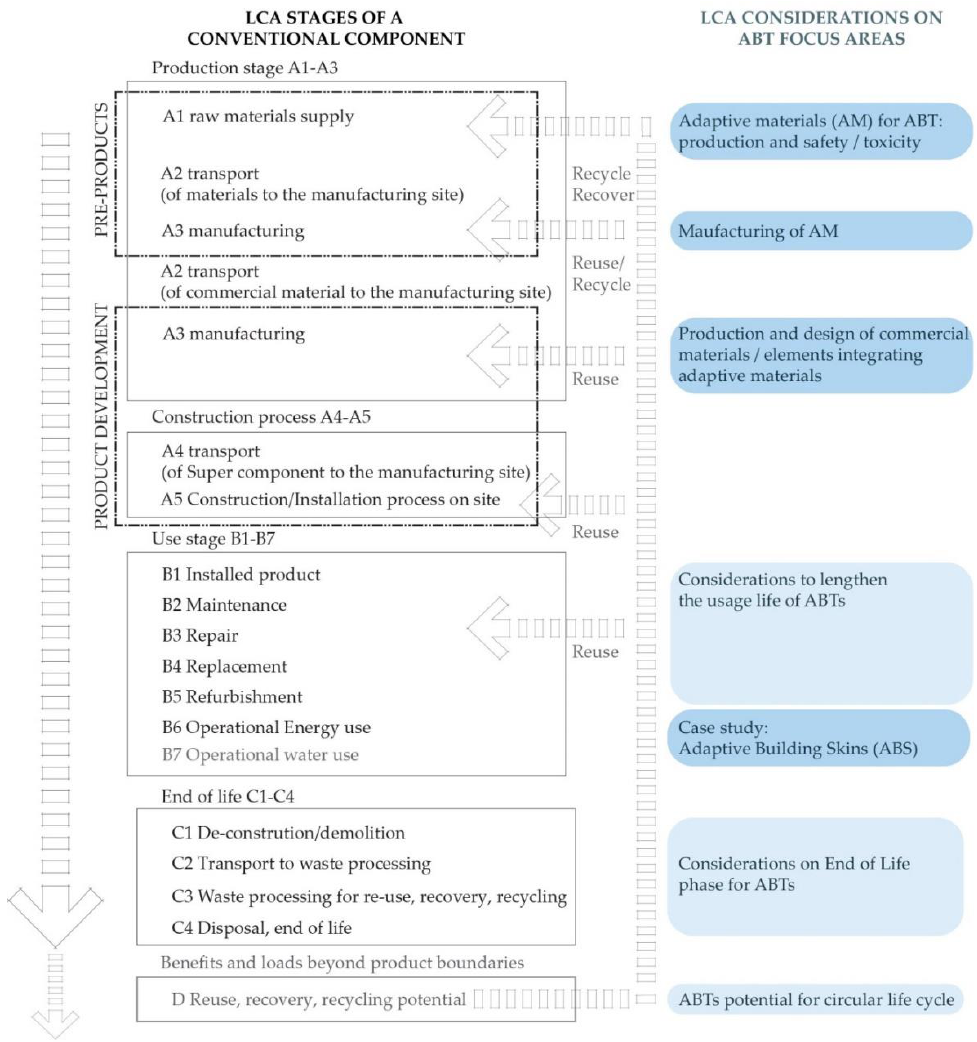
Figure 3. Life Cycle Assessment (LCA) phases of a conventional building component [39], and areas of focused study.